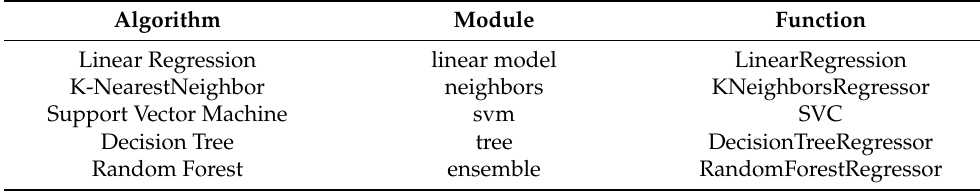
Table 1. Five commonly used classifiers.